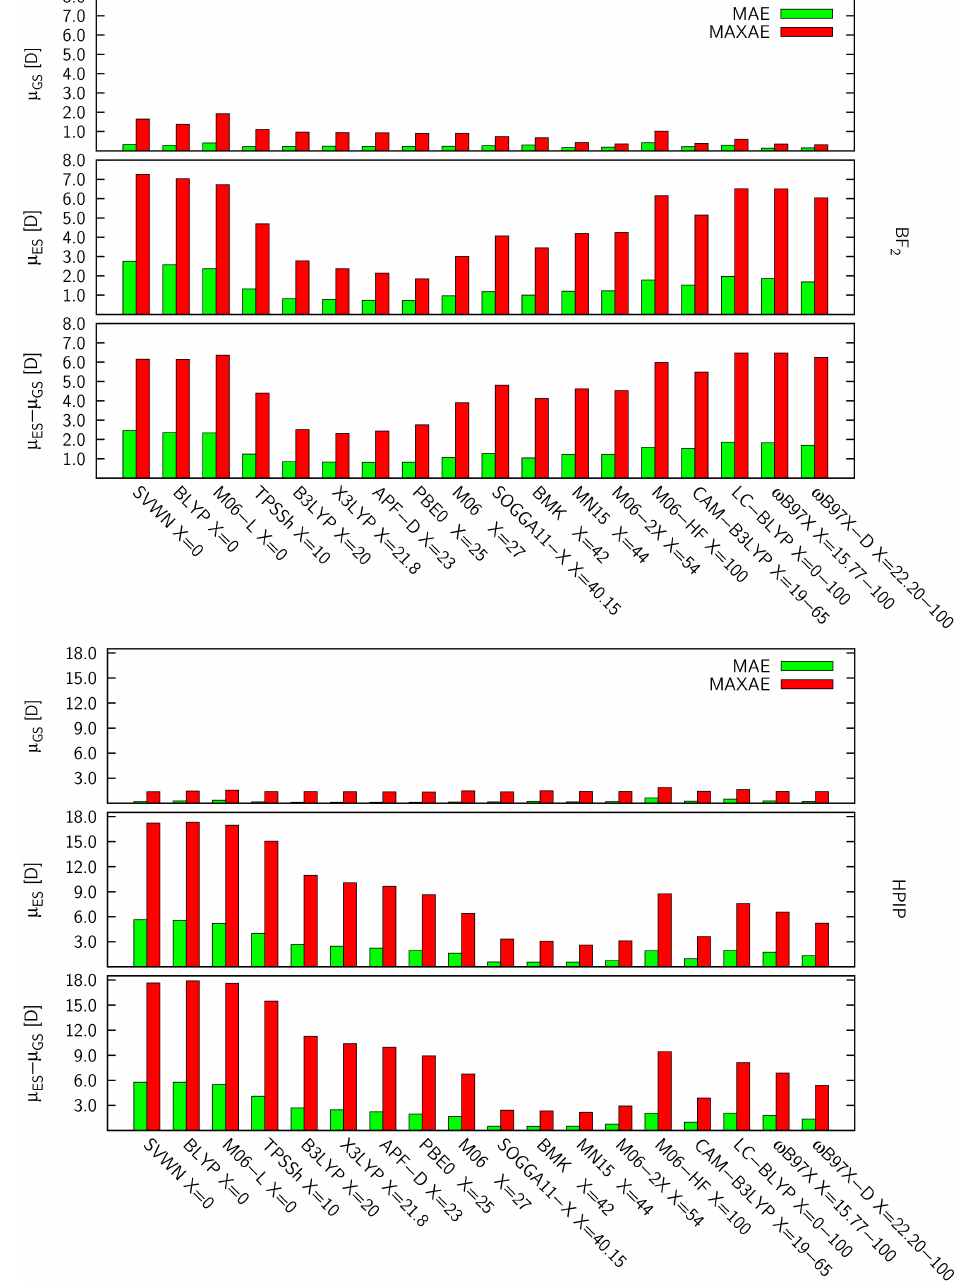
Figure 4. DFA errors established for the dipole moments (determined with respect to